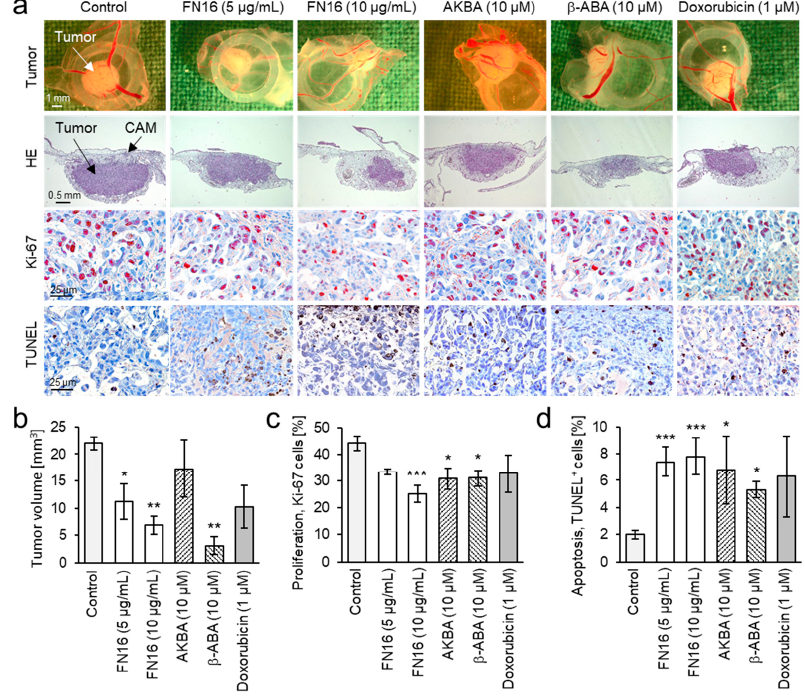
Figure 6. FNs and BAs inhibit growth and induce apoptosis in TNBC breast cancer xenografts in vivo. MDA-MB-231 cells were grafted on the chorioallantoic membrane (CAM) of fertilized chick eggs and treated for 3 consecutive days with either FN16 (5 mg / mL and 10 mg / mL), the boswellic acids AKBA or β -ABA (each 10 µ M), doxorubicin (1 µ M), or DMSO (0.5%) as control. ( a ) First row: tumor photographs immediately after extraction (original magnification 50 × ). Second row: hematoxylin and eosin staining. Third row: staining for proliferation marker Ki-67 (red-brown nuclear stain, original magnification 200 × ). Fourth row: staining for the apoptosis marker TUNEL (brown, original magnification 200 × ). ( b ) FN16 and β -ABA inhibit the tumor growth. ( c ) FN16, AKBA, and β -ABA inhibit cancer cell proliferation. ( d ) FN16, AKBA, and β -ABA induce apoptosis in cancer xenografts. All data are mean ± SEM, n = 4. Comparison with control by Kruskal-Wallis one-way ANOVA on ranks and post-hoc by Dunn’s test with * p < 0.05, ** p < 0.01, and *** p <